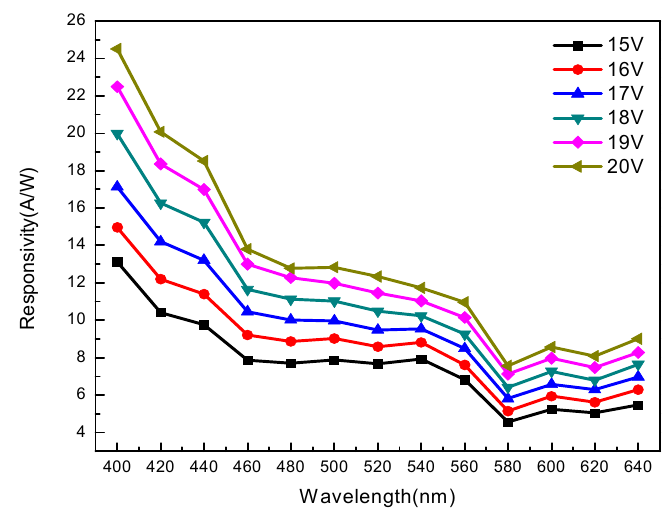
Figure 10. Responsivity and wavelength curve of MSM-MAPbBr 3 crystal photodetectors.